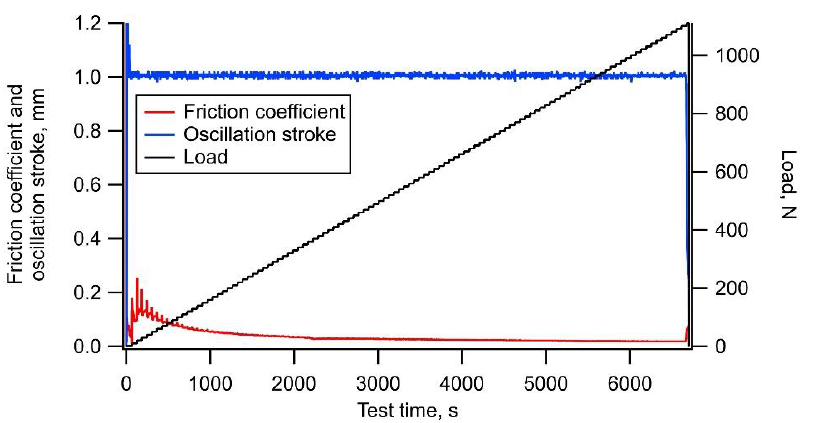
Figure 5. Typical example of trends of friction coefficient, oscillation stroke, and load during test using a-C:H film.